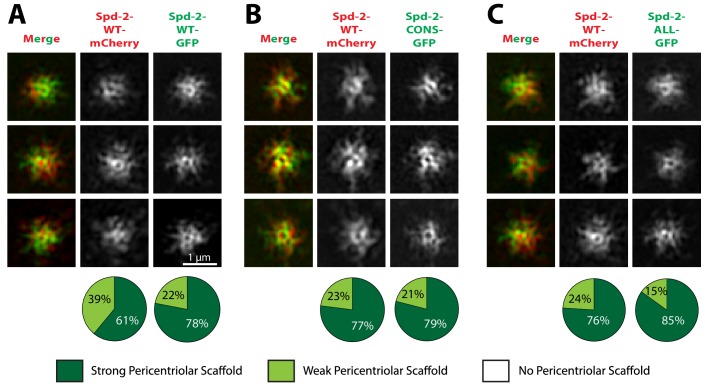
Spd-2-CONS and Spd-2-ALL can efficiently assemble into a PCM scaffold formed by WT Spd-2.(A-C) Micrographs show 3D-SIM images of individual centrosomes from Spd-2 mutant embryos expressing WT Spd-2-mCherry and one copy of either WT Spd-2-GFP (A), Spd-2-CONS-GFP (B) or Spd-2-ALL-GFP (C). Pie charts quantify the percentage of centrosomes that were scored qualitatively as having a strong (dark green), weak (light green) or no (white) pericentriolar scaffold (n = 16 individual centrosomes, two images (channels) per centrosome, for each genotype, respectively). All centrosomes were imaged in mid-late S-phase when the centrosomal levels of Spd-2 are maximal (see Figure 8). All scorings were performed blind by researchers not involved in the data acquisition.10.7554/eLife.50130.022Figure 5—source data 1.Figure 5A–C source data, results from blind scoring.